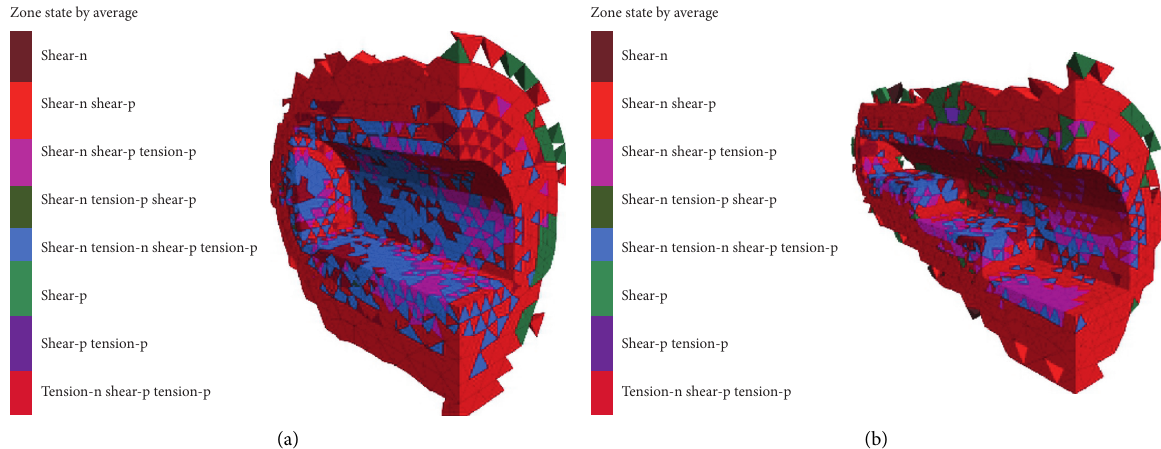
Figure 12: Plastic zone of stepped driving. (a) Nonstepped driving. (b) Stepped driving.